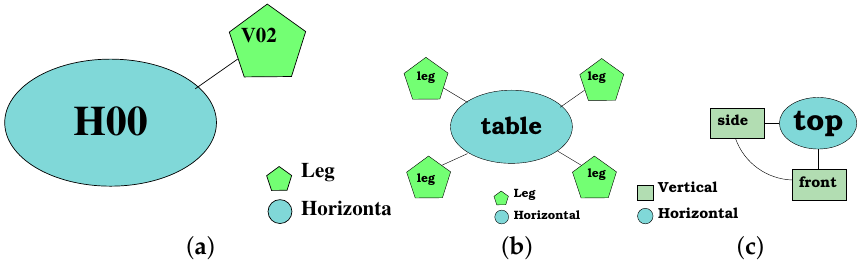
Figure 15. Graph comparison: in ( a ), one of the graphs generated from the scene in Figure 14b; in ( b , c ), partial graphs selected for matching with the graph in ( a ), corresponding to the table and the chest of drawers.